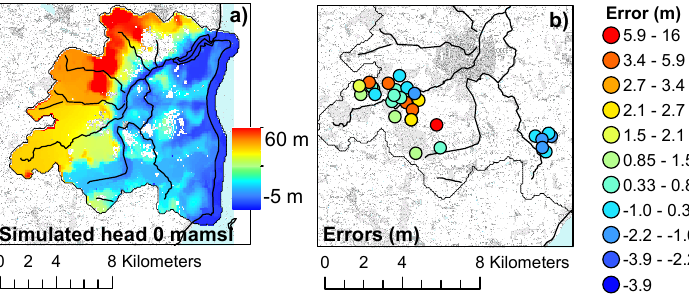
Figure 12. Distributed head results for the validation period 1995–1999; (a) 5-cluster model simulated hydraulic head at 27 July 1997 at 0ma.m.s.l; (b) Errors (observed–simulated) between observed and simulated head.